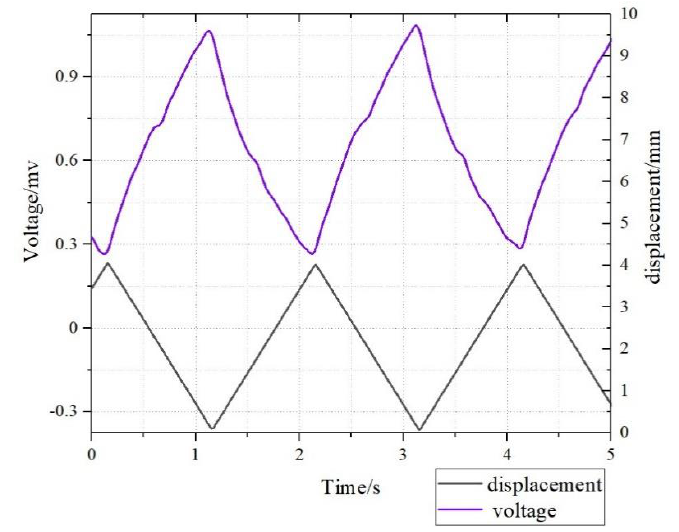
Figure 7. The deformation sensing of the L3 sample with triangular wave signal.